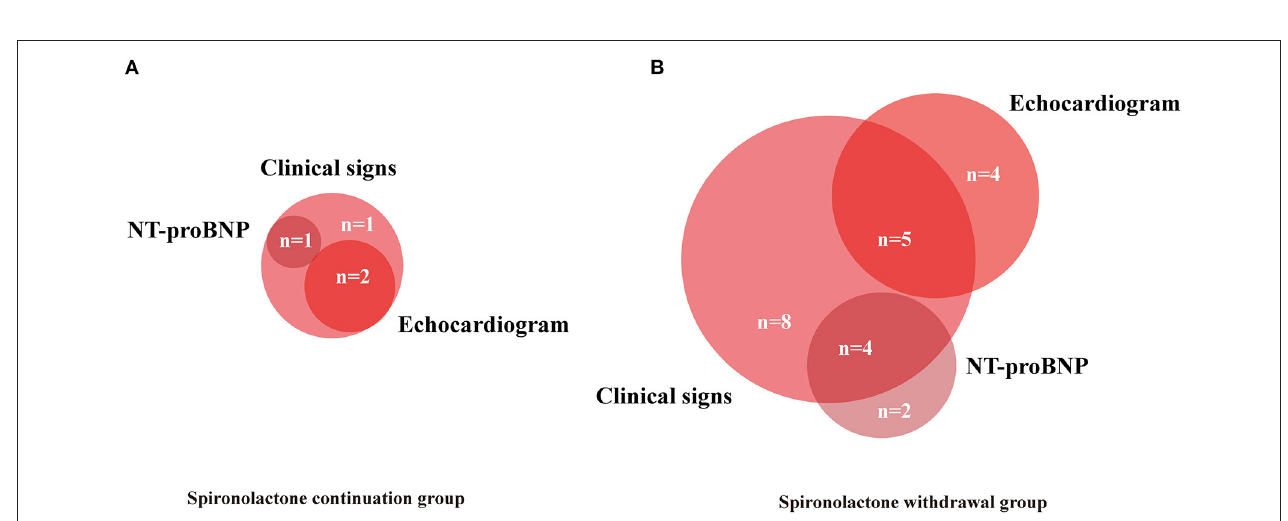
FIGURE 2 | Primary endpoints analysis. (A) Proportion of patients who met the primary endpoint in either group. (B) Detailed distribution of patients who met one criterion for relapse in each group. RR, relative risk for relapse in the withdrawal group; NT-proBNP, N-terminal pro-B-type natriuretic peptide.